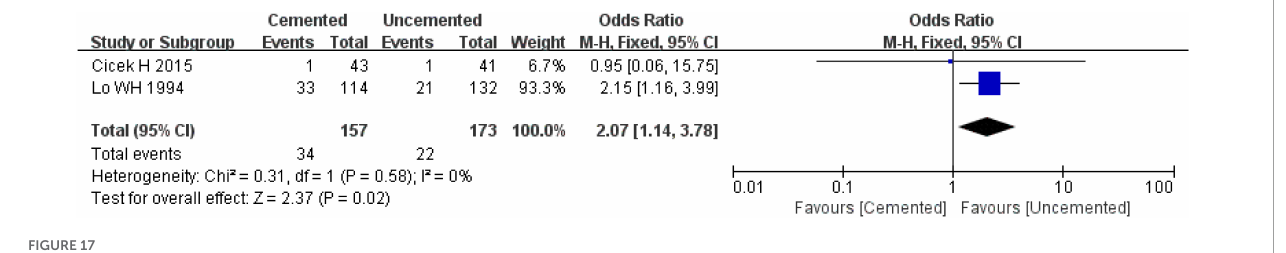
FIGURE17 Forest plot for comparison of heterotopic ossifications between cemented bipolar hemiarthroplasty (CBH) group and uncemented bipolar hemiarthroplasty (UCBH) group.